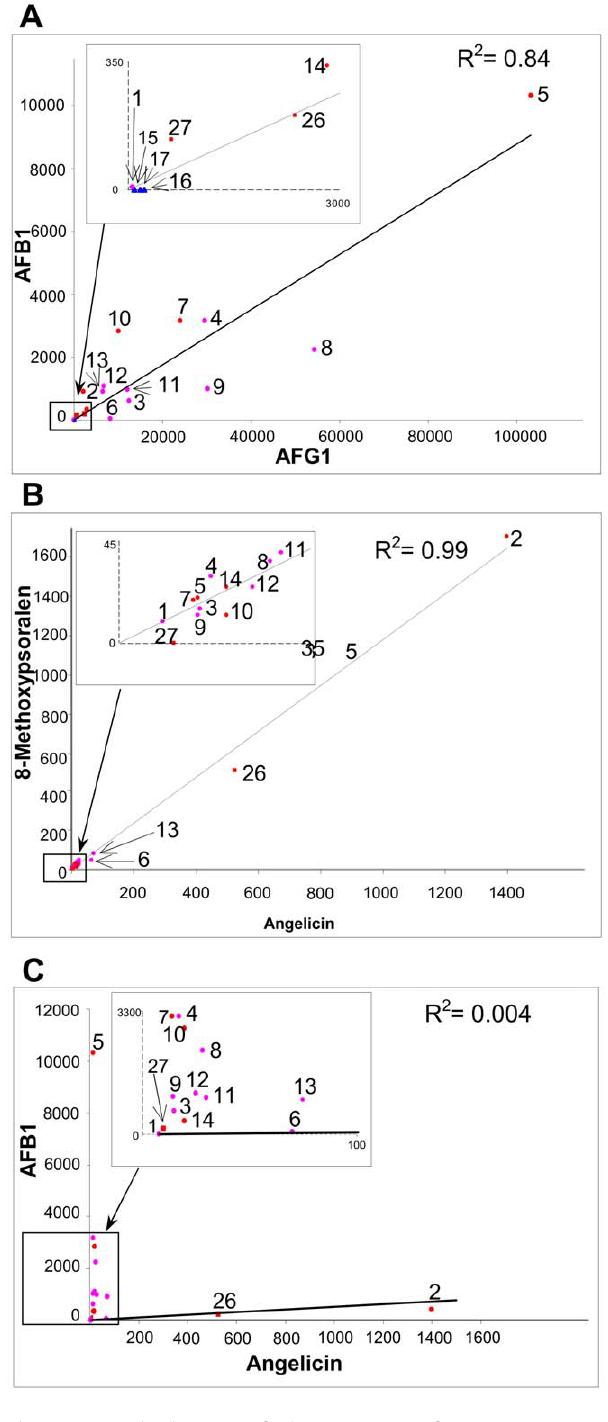
Figure 3. Pairwise correlations among the AFB1, AFG1, angelicin and 8-methoxypsoralen activities of FDR-A1/2/3 and FDR-B enzymes. The R 2 values for each pair of activities are given on each graph. Enzymes are numbered as per Fig. 2.